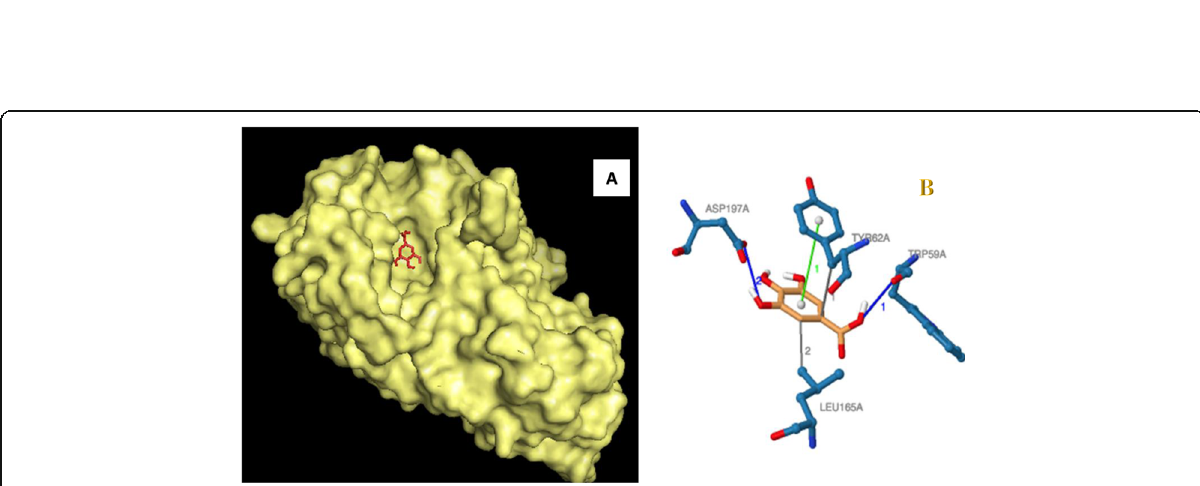
Fig. 10 Binding pose and binding site of gallic acid with α -amylase (panel A), molecular interaction of gallic acid with amino acid residues within the binding pocket of the protein structure (panel